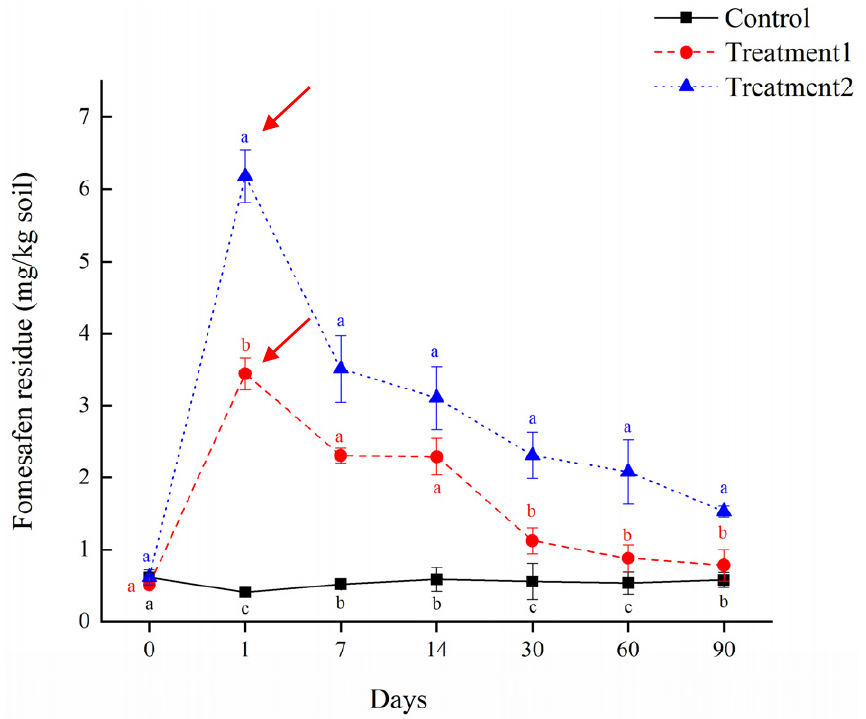
Figure 1. Residue dynamics of fomesafen at the recommended level and double the recommended level. Note: the red arrow indicates the date of application. Data represent the mean ± SD of each soil sample selected at each time point. The UNIANOVA with Duncan’s homogeneity test was per-formed between the control group and the treatment group, with different letters indicating